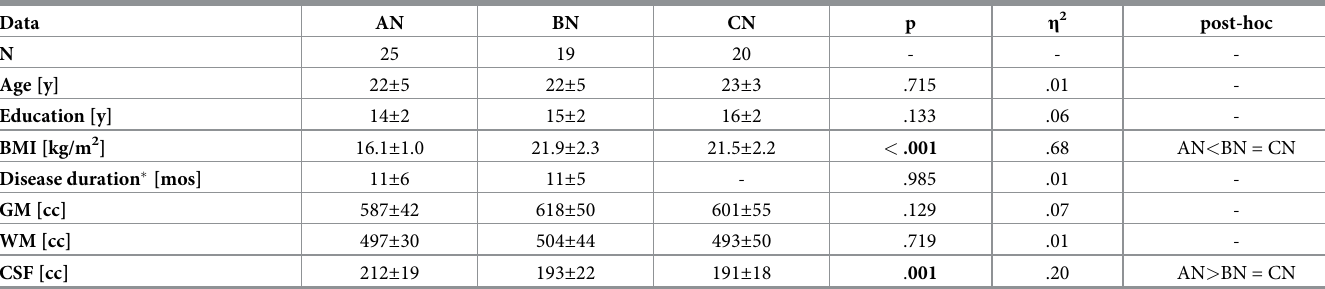
Table 1. Demographic and clinical data separately for the three groups.